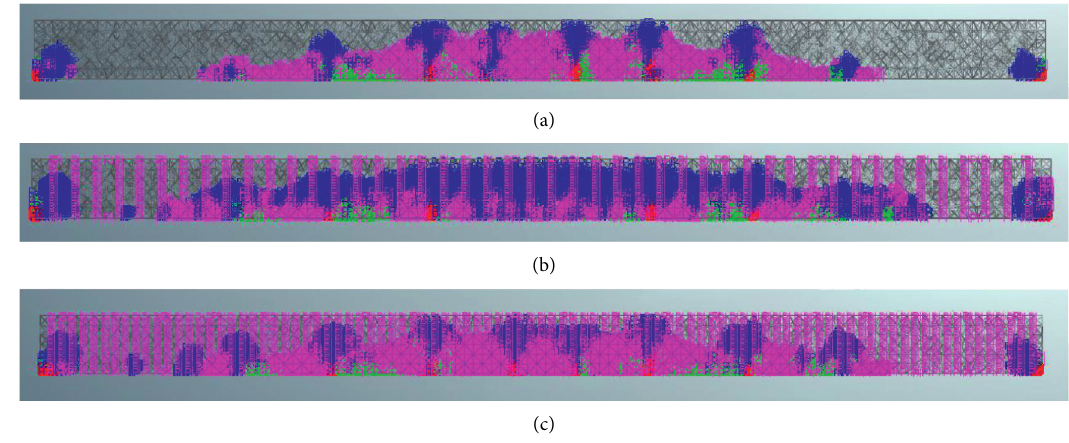
Figure 19: Crack pattern when the first crack opening: (a) B-Control, (b) CFRP and (c) BP.